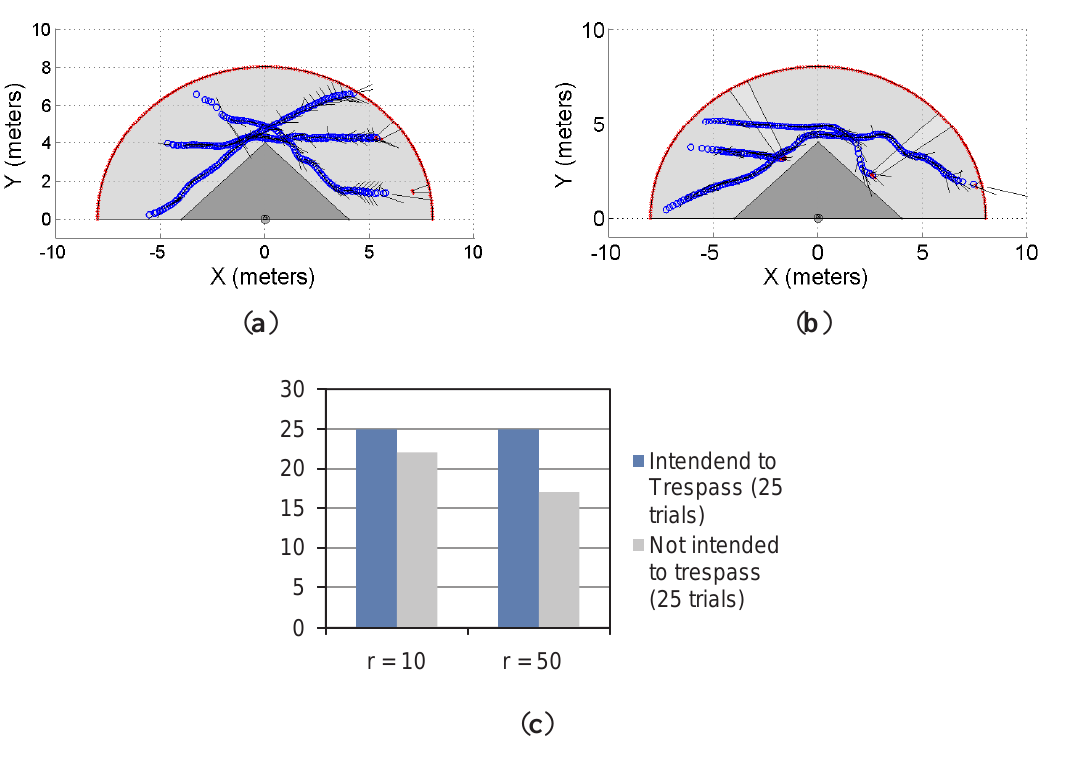
Figure 7. First approach of the multi-object detection using a single laser sensor. ( a , b ) two examples; ( c ) the statistical results of the experiment.